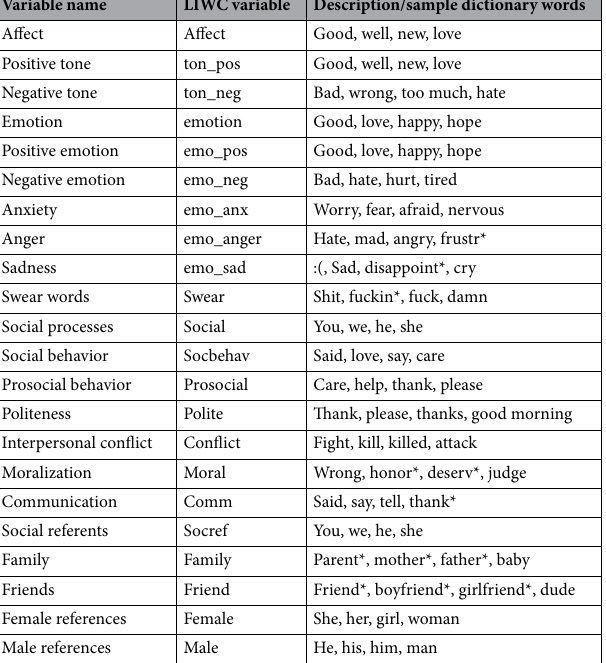
Table 2. LIWC variable names, descriptions, and examples of words from each variable’s dictionary for 23 variables that measure social-related and affect-related aspects of texts. Text analysis